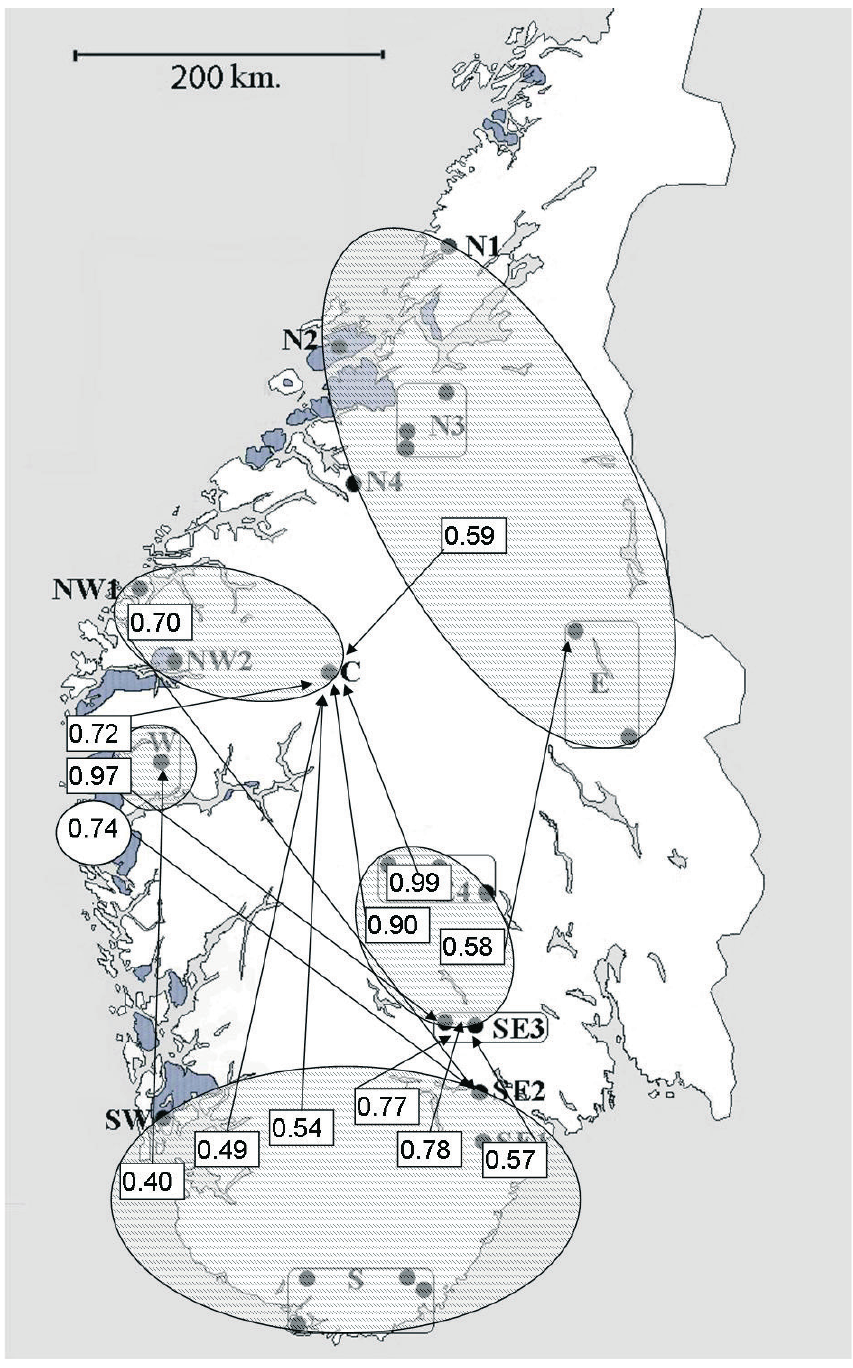
Fig. S1. Norwegian red deer long-distance dispersers identified through STRUC- TURE with priors on which subpopulation each individual was sampled, their sex (rectangle=male, circle=female), sampling location (arrow points to, indicating the di- rection of dispersal, and the likelihood of assignment (coefficient